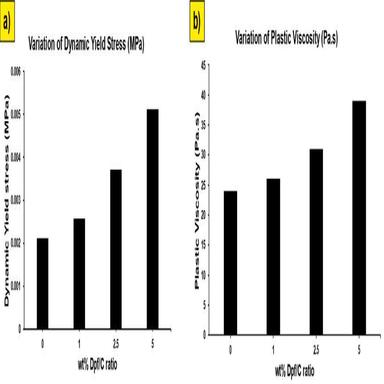
Bar chart demonstrating variation of (a) dynamic yield stress and (b) plastic viscosity with the variation of Dpf/C ratio.